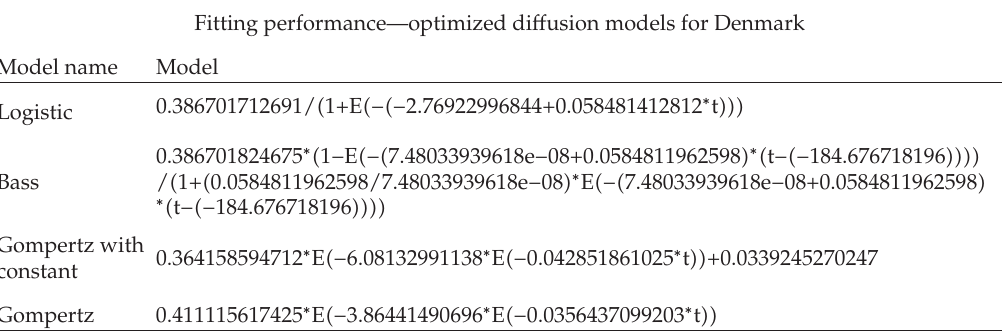
Table 28: Representation of the optimized di ff usion models in fitting (cid:2) Denmark (cid:3) . Fitting performance—optimized di ff usion models for